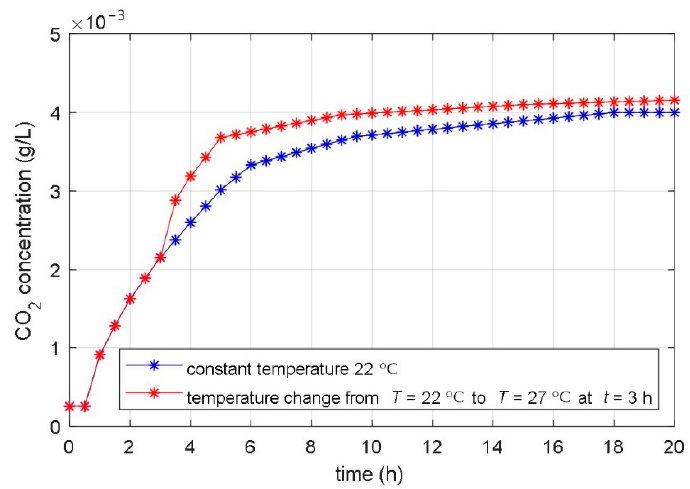
Figure 3. Measured time courses of the CO 2 concentration during the fermentation processes with constant and changeable bioreactor temperatures.